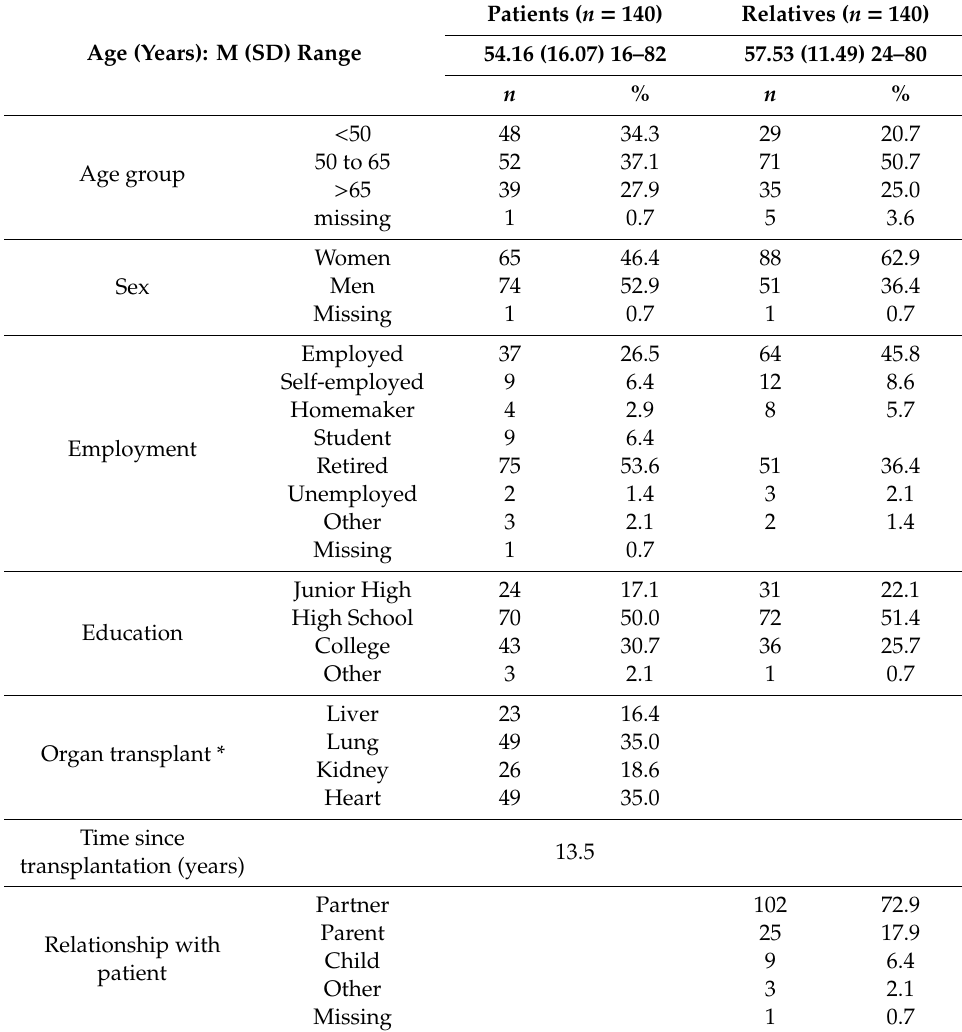
Table 1. Demographic characteristics of organ transplant patients and their